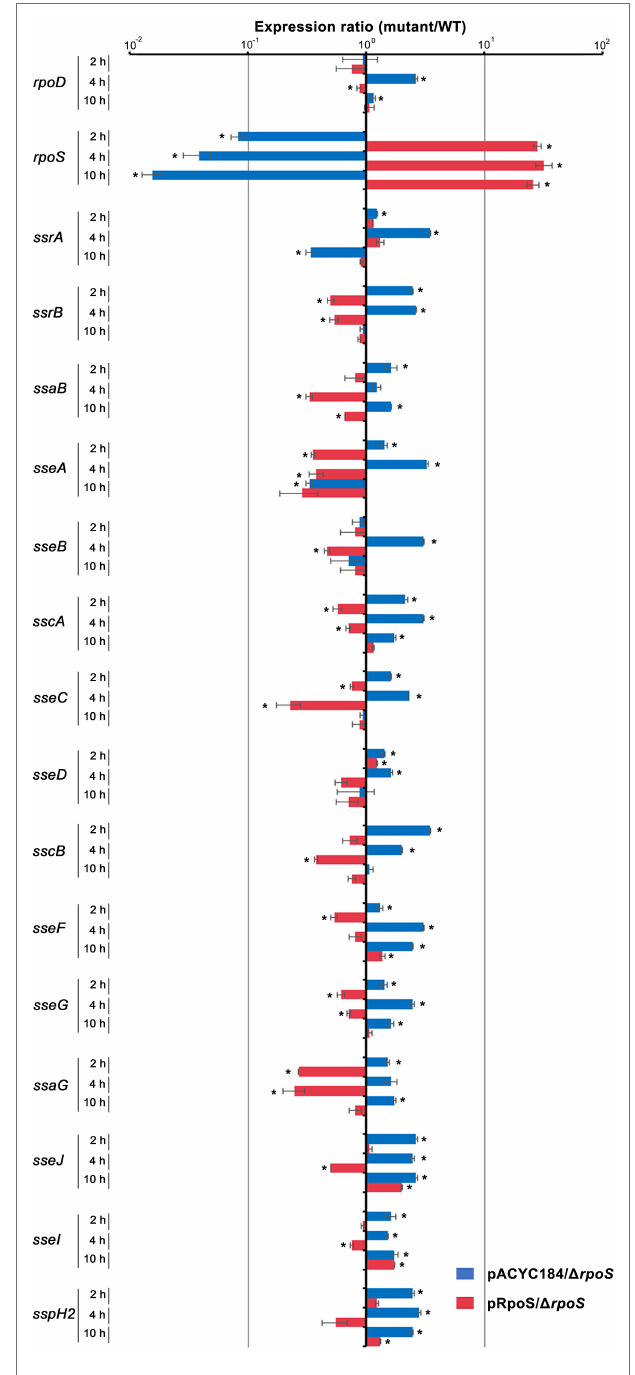
FIGURE 9 | Transcriptional regulation of SPI-2 genes by σ S . Salmonella wild-type and Δ rpoS mutant strains containing pRpoS or pACYC184 were added to RAW264.7, and total RNA was isolated at 2, 4, and 10 h post-infection and used to measure the transcription levels of genes, including rpoD , rpoS , and SPI-2 T3SS-associated genes. The Ct values for each gene were normalized to those of gyrB . Expression levels of each gene from Δ rpoS mutant strains containing pRpoS or pACYC184 were compared with those from wild-type strain containing pACYC184 and the fold-change (mutant/wild-type) was plotted. An asterisk indicates a value of p < 0.05 in comparison with wild-type strain harboring